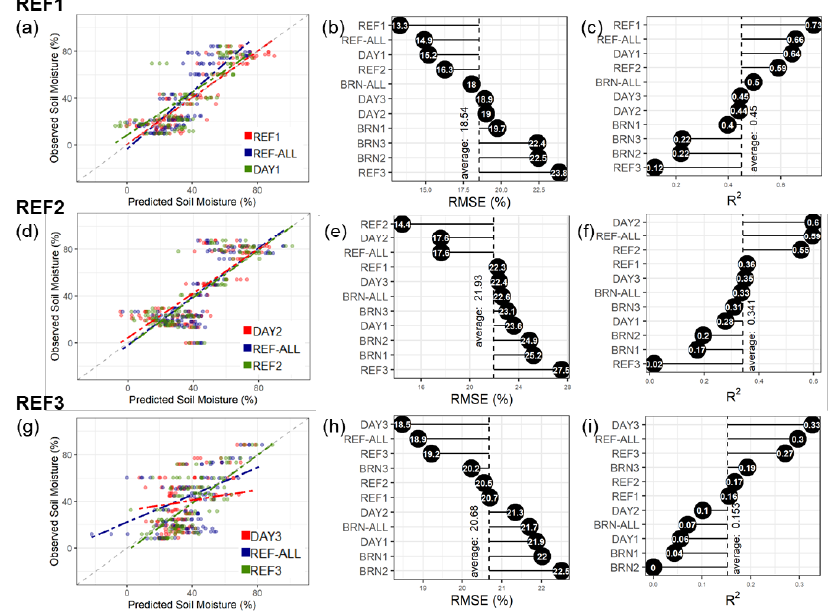
Figure 8. Summary plots of model validation using site-specific and independent datasets. The left panels display the scatterplot of the three best performance models for ( a ) REF1 dataset, ( d ) REF2 dataset, and ( g ) REF3 dataset. The center panels present the ranking of models’ root-mean-square error (RMSE) for ( b ) REF1 dataset, ( e ) REF2 dataset, and ( h ) REF3 dataset. The right panels present the ranking of models’ coefficient of determination (R 2 ) for ( c ) REF1 dataset, ( f ) REF2 dataset, and ( i ) REF3 dataset.